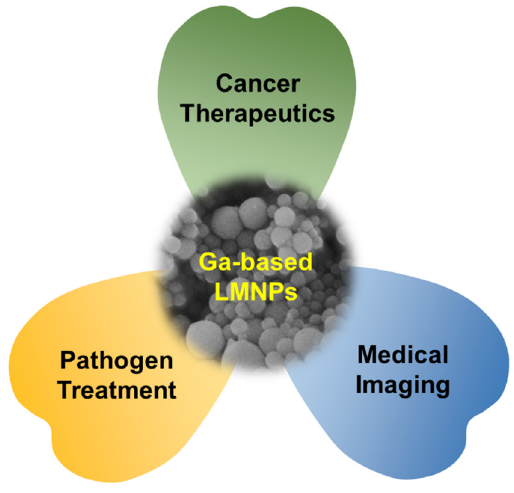
Figure 1. Biomedical applications enabled by Ga-based liquid metal nanoparticles (LMNPs).